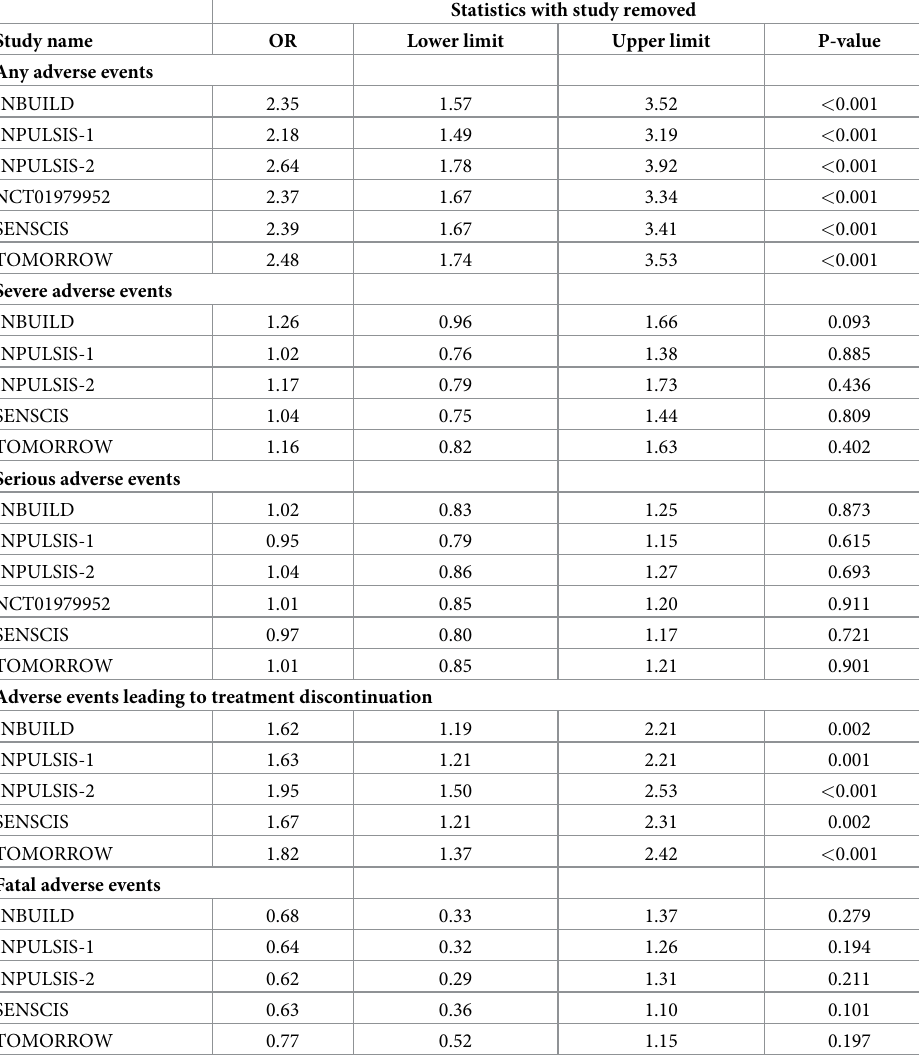
Table 3. Leave-one-out sensitivity analyses for adverse